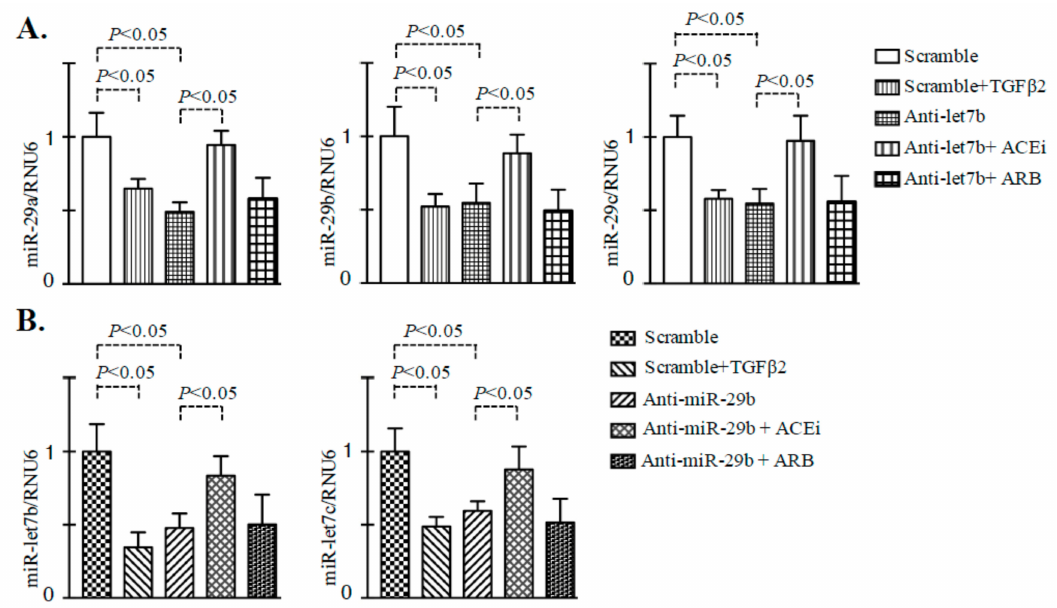
Figure 6. Inhibition of ACE restored the TGF β 2-associated disruption of cross-talk regulation between miR-29 and miR-let-7 family members in the endothelial cells. ( A ) Gene expression analysis of miR-29 family members in the anti-miR-let-7b transfected HMVECs, ACEi + anti-miR-let-7b transfected, andARB + anti-miR-let-7btransfectedHMVECs. N = 4wereanalyzedineachgroup. ( B )Geneexpression studies of miR-let-7b and miR-let-7c in the anti-miR-29b transfected HMVECs, ACEi + anti-miR-29b transfected, and ARB + anti-miR-29b transfected HMVECs. N = 4 were analyzed in each group. Data in the graph are presented as mean ± SEM. One-way Anova Tukey test was performed for calculation of statistical